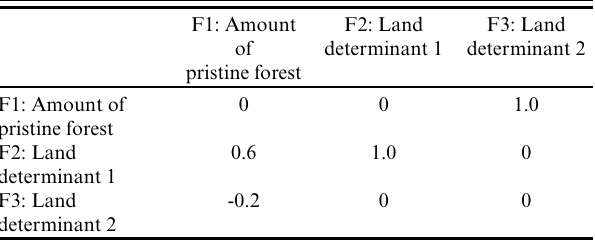
Table 1 . Tabular representation of all possible relationships between the three factors shown in Figure 1 for the initial